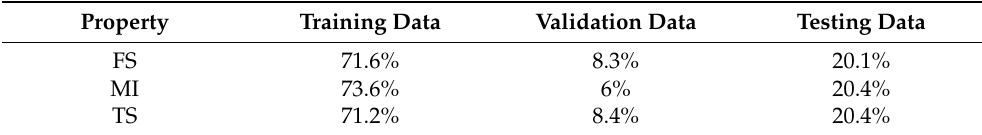
Table 4. Percentage of datasets per physical